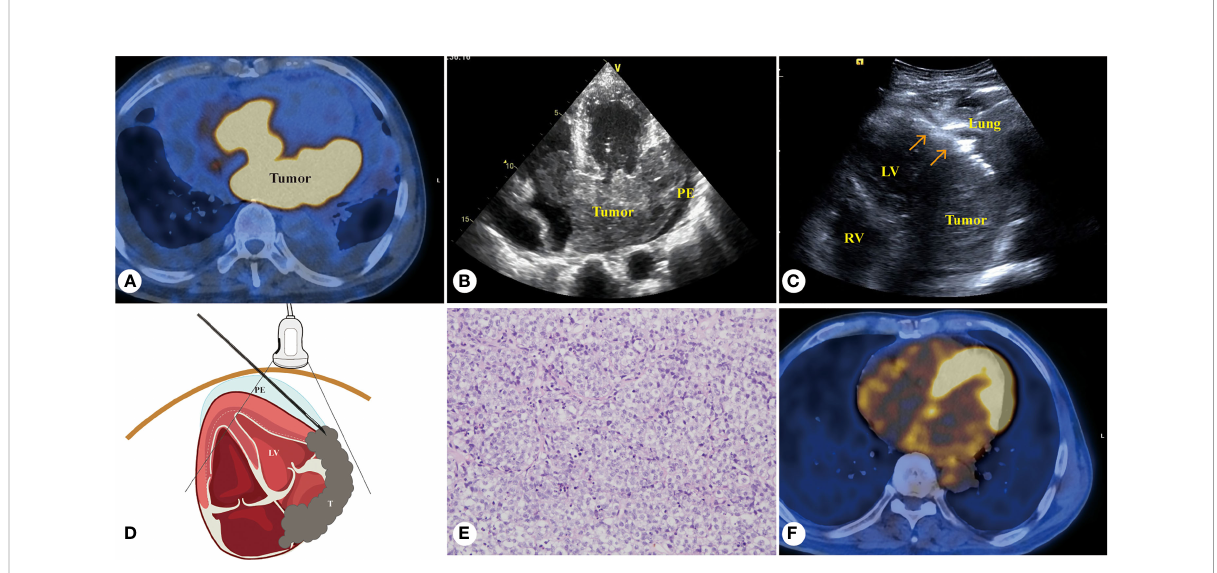
FIGURE 1 Sixty- fi ve-year-old male patient, diffuse large B-cell lymphoma of the heart. (A) PET/CT revealed abnormal concentrated lesion (SUV 12.3 – 26.5) of the heart. (B) Echocardiography revealed the tumor invading the left atrial wall, atrial septum, atrioventricular valve, and right ventricle. (C) PUS-CNB of left atrial wall tumor (red arrow shows the biopsy needle is parallel with the myocardial wall). (D) Schematic diagram of PUS-CNB. (E) The microscopic features showed diffuse patches of medium to large atypical lymphocytes (H&E, × 200). (F) After 4 courses of chemotherapy, PET/CT showed that the lymphoma lesion disappeared. LA, left atrium; LV, left ventricle; RV, right ventricle; RA, right ventricle; T, tumor; PE, pericardial